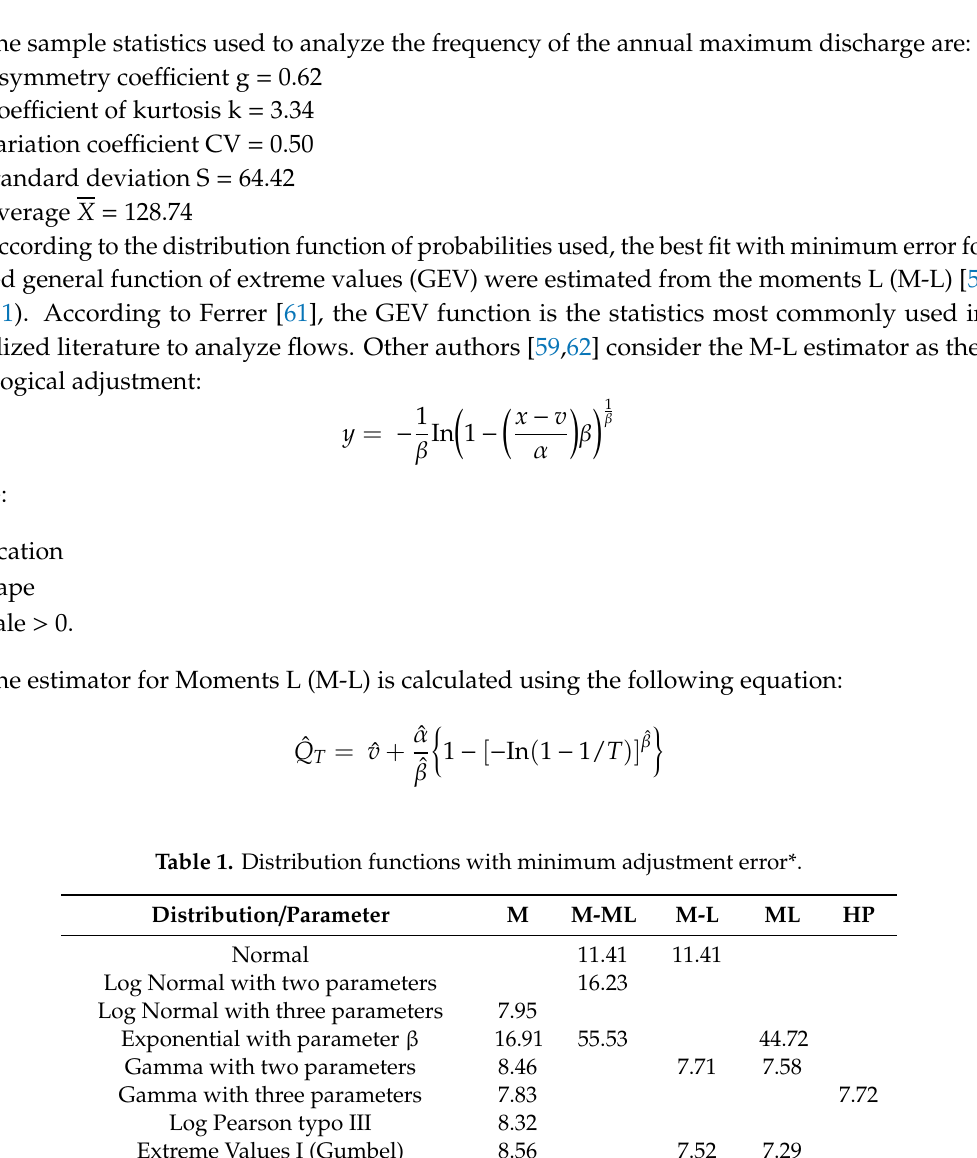
Figure 3. Correlation diagram of the data series.